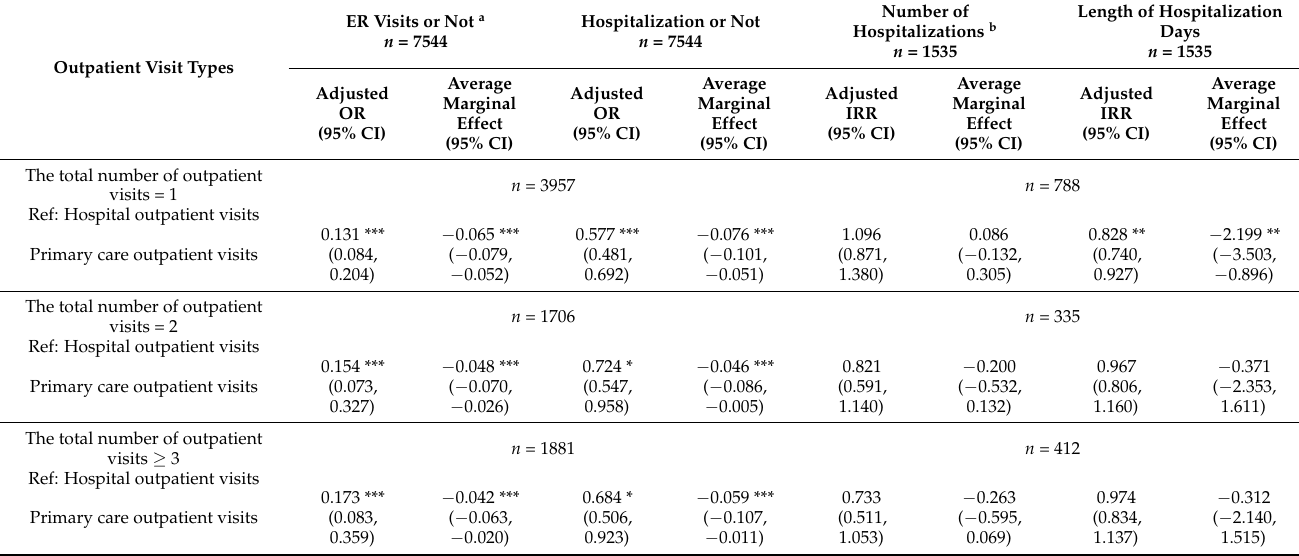
Table 5. Trend test of association between the outpatient visit types and ER or hospital inpatient services utilization among middle-aged and elderly Chinese